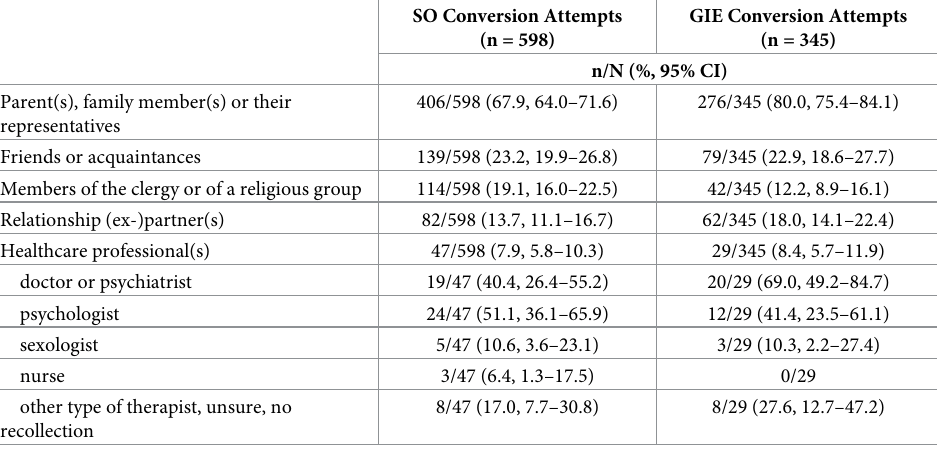
Table 4. Types of persons who have tried at any time to change participants’